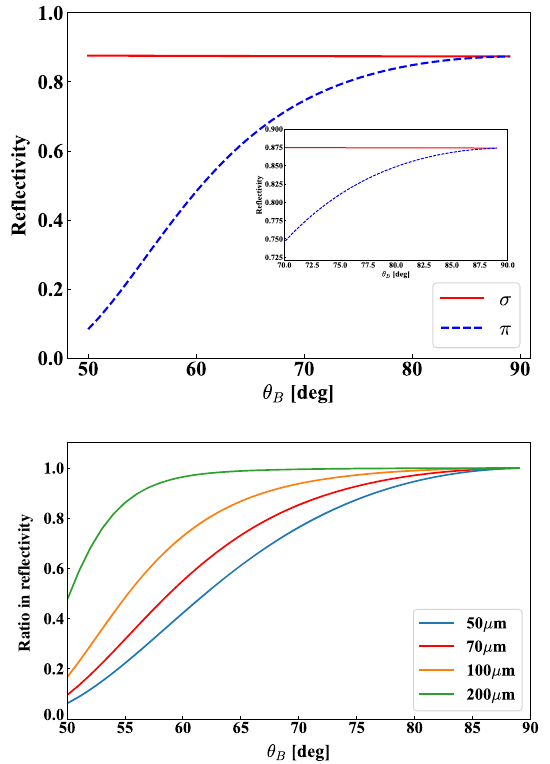
FIG. 9. The rocking curves with the additional phase difference between the horizontally polarized and the vertically polarized components are shown. The calculated results are based on the dynamical theory of x-ray diffraction when Θ is 1°, 10°, 20°, and 40°.